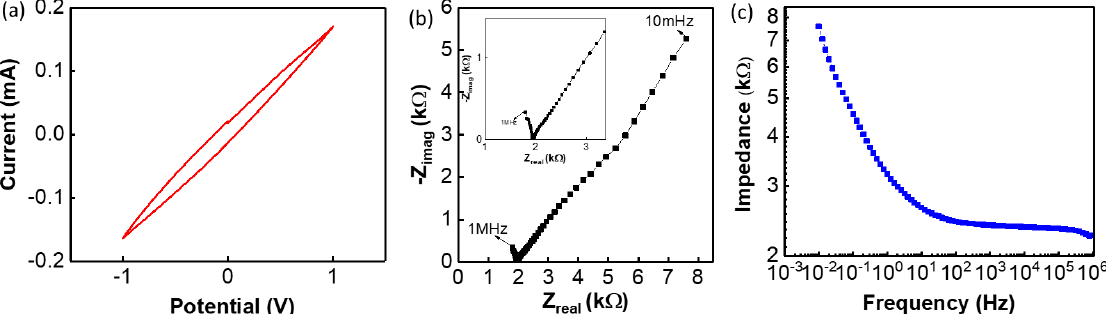
Figure 5. Electrochemical reaction of cloth and G-PU electrode: ( a ) cyclic voltammetry (CV) analysis for pH 7, ( b ) Nyquist plot (inset shows the high frequency), and ( c ) Bode impedance plot of the SE at pH 7 with a frequency range of 10 mHz to 1 MHz.